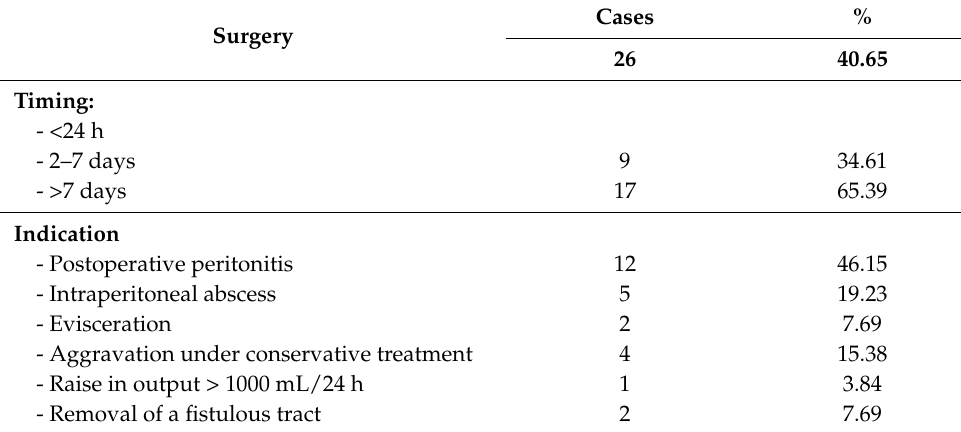
Table 2. Surgery: timing, indications.